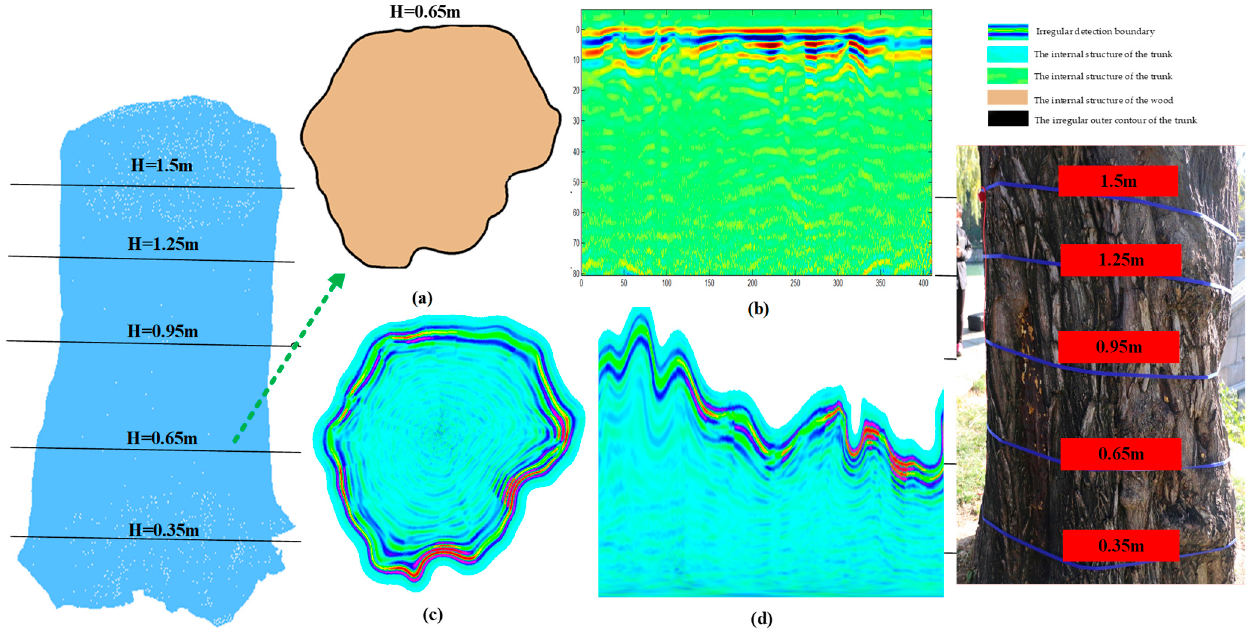
Figure 13. Radar images of the living tree. ( a ) Black curve is the contour of the irregular tree trunk at h = 0.65 m; ( b ) radar data measured at h = 0.65 m; ( c ) actual irregular radar image at h = 0.65 m; ( d ) radar images in the physical domain.